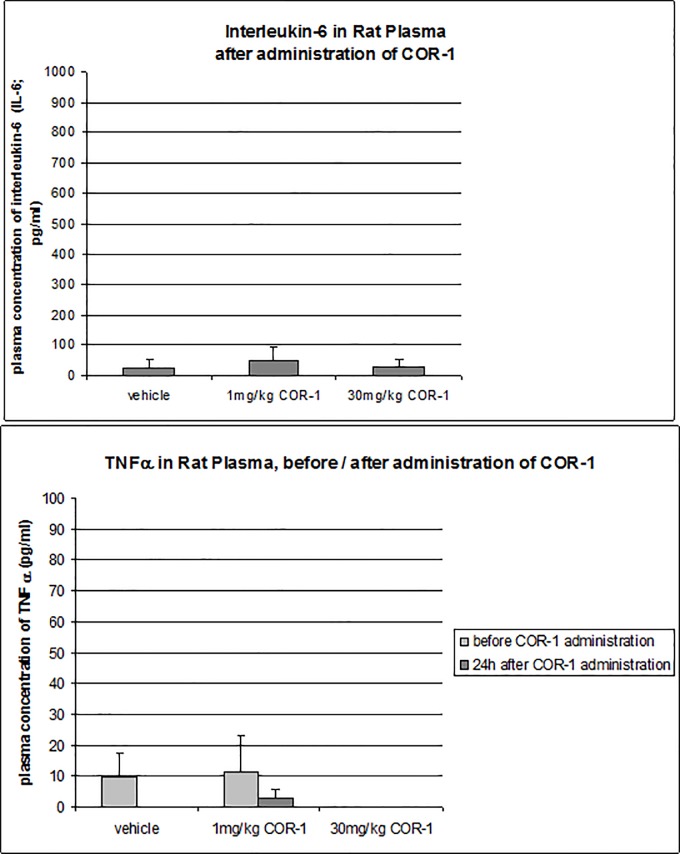
Effect of COR-1 on the plasma levels of interleukin (IL)-6 and tumor necrosis factor (TNF)-alpha.Spleen cells prepared from HF rats which received 10 monthly treatments with either vehicle (n = 8) or 1 mg/kg or 30 mg/kg COR-1 (n = 8 each) were assessed for plasma levels of IL-6 after treatment (A) and TNF-alpha before and after treatment (B).There were no significant differences between groups.